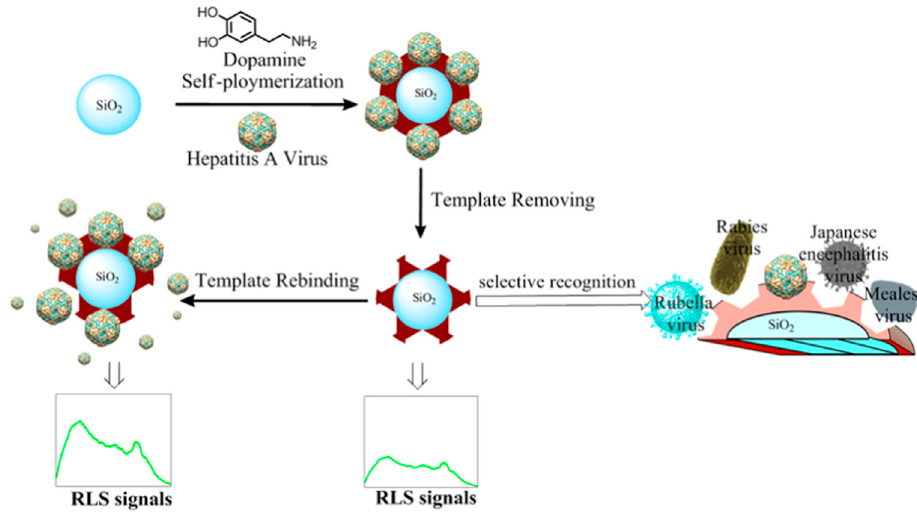
Figure 3. Principle of preparation of the virus-MIPs and detection of virus (Reproduced with per- mission from Reference